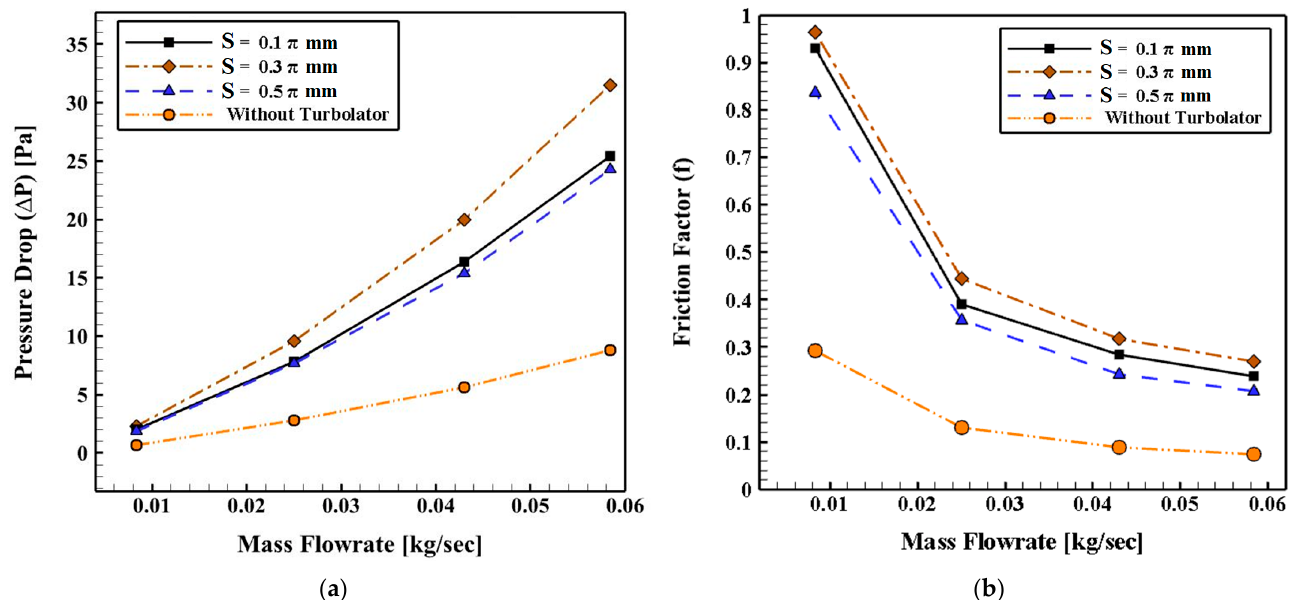
Figure 16. The deviations of ( a ) pressure loss and ( b ) friction factor with mass flow rates for various positions of the proposed swirl generator at θ = 180 degrees, n = 12, R 0 =19 mm, r = 8.4 mm, L 1 = 100 mm, and m (cid:4662) = 0.043 kg/s.